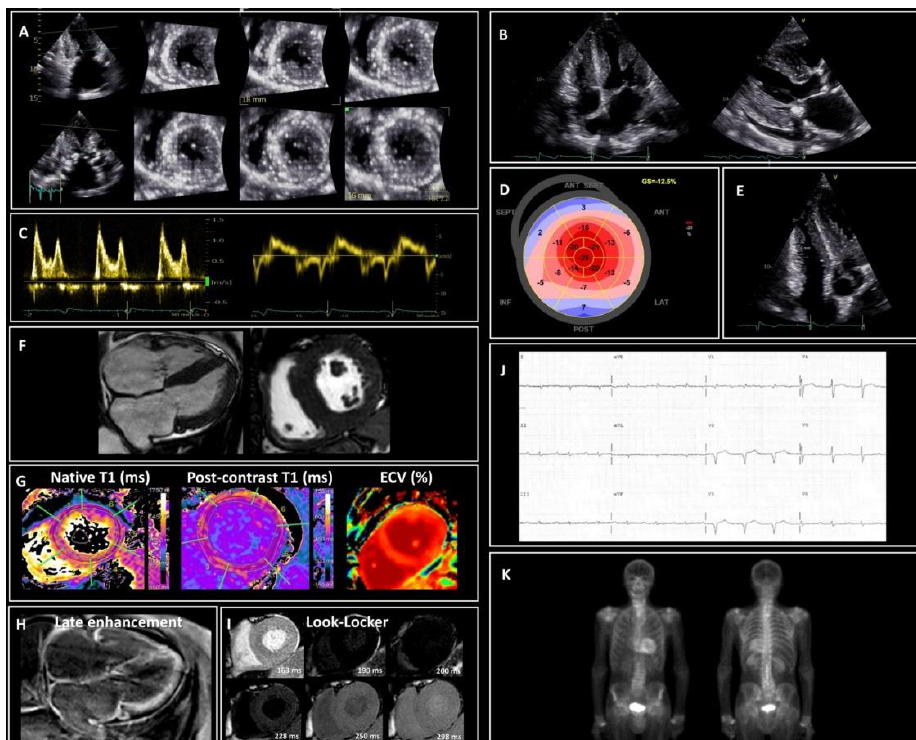
Figure 2. Red flags of cardiac amyloidosis (CA). ( A–E ) Typical echocardiographic features of CA. ( A ) Left ventricle (LV) short-axis slices obtained from a 3D dataset showing severe LV hypertrophy and myocardial granular sparkling. ( B ) 4-Chamber view and parasternal long-axis showing an increase of left and right ventricular walls thickness, left atrial dilatation, atrial septal thickening and pericardial effusion. ( C ) Pulsed wave Doppler of the mitral valve inflow reveals restrictive filling pattern (grade III diastolic dysfunction) with marked reduced lateral mitral annular diastolic velocity (e (cid:48) 4.8 cm/sec at the tissue Doppler analysis); tissue Doppler signals from the lateral mitral annulus shows longitudinal systolic dysfunction with mitral S (cid:48) ≤ 6 cm/s. ( D ) Speckle tracking imaging showing a depressed LV global longitudinal strain ( − 12%) with apical sparing and an apex/basal longitudinal strain ratio > 2. ( E ) Focused right ventricle (RV) view showing RV wall thickening ( ≥ 5 mm). ( F – I ) Typical cardiac magnetic resonance (CMR) features of CA. ( F ) Steady-state free precession sequences (SSFP) showing diffuse and asymmetric hypertrophy of the LV and RV. ( G ) T1-mapping reveals prolongation of the native relaxation time and of the extracellular volume (ECV). ( H ) Typical late gadolimium enhancement (LGE) pattern: LGE is extensive and circumferential, starts from the subendocardium and predominates at the basal segments with a base-to-apex gradient in a non-ischemic pattern; sub-optimal nulling of myocardium is present, and the blood pool has a signal darker than the myocardium; LGE is also evident in the RV wall, atria walls and atrial septum. ( I ) Frames from Look–Locker inversion recovery sequences (T1 scout) showing altered gadolinium kinetics in ATTR-CA: evidence of reverse order of sequences with the myocardium passing through the null-point before the blood pool. ( J ) Typical ECG findings of CA: discordance between low-voltage and LV wall thickness; discordance between the voltages in peripheral and precordial leads; pseudo-infarction pattern (Q waves) without history of myocardial infarction; right axis deviation; abnormal P wave duration and morphology reflecting slow atrial conduction. ( K ) 99m Tc-hydroxymethylene diphosphonate scintigraphy showing strong cardiac uptake (Perugini Grade